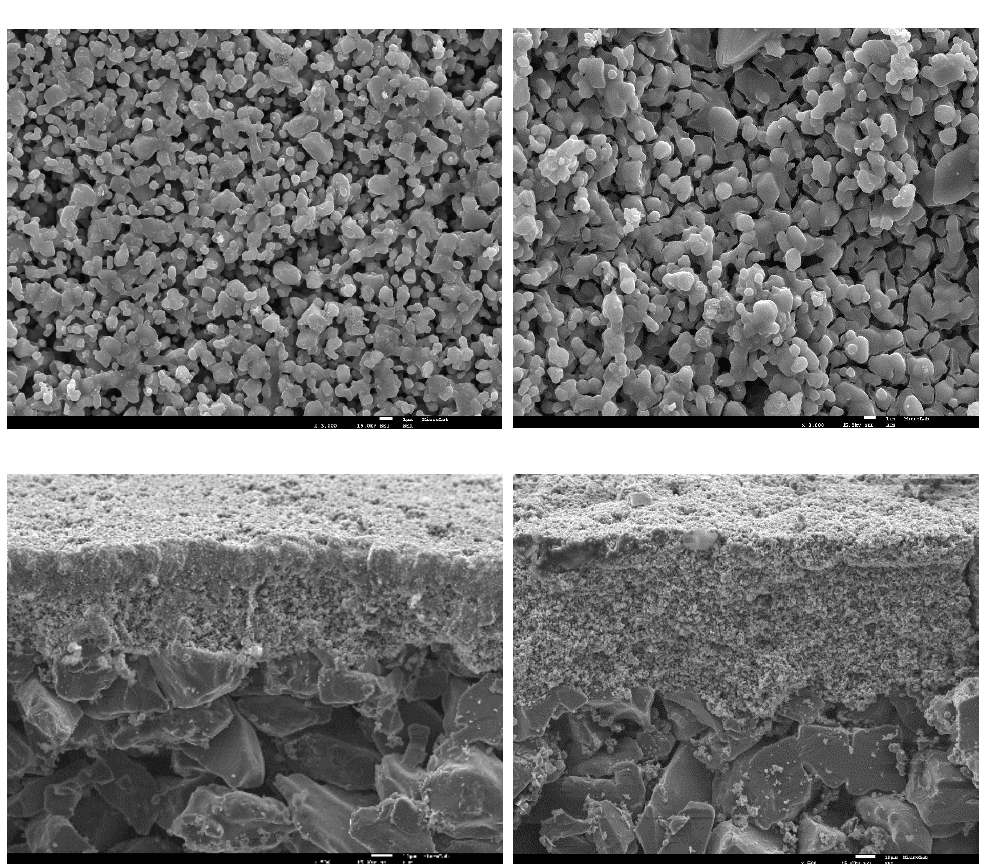
Figure 1. Scanning electron microscopy for the unmodified (UM) and the modified membrane (MMCu): top surface ( up ) and cross section ( down ) analysed at ×3000 and ×500 magnification, respectively. Table 1. Porous properties estimated in two zones (Z1 and Z2), for the membranes described in this work (magnification of ×